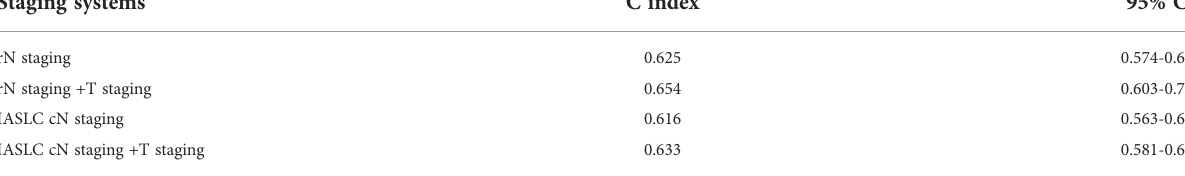
TABLE 4 Comparison of the C index of different staging systems. Staging